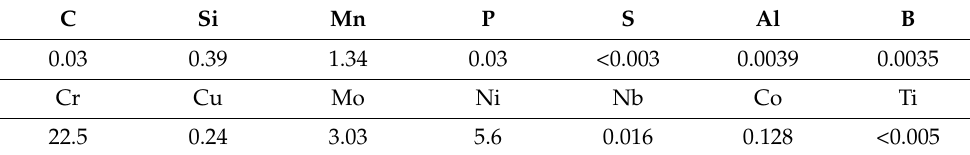
Table 1. Chemical composition of duplex 2205